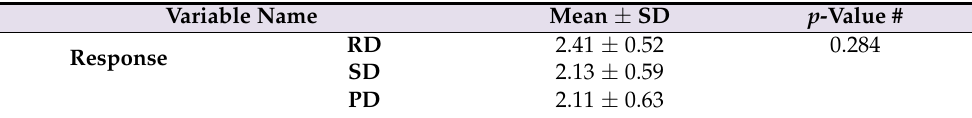
Table 4. Metformin concentration according to the response status of the studied participants after 6 months of treatment (n = 51).